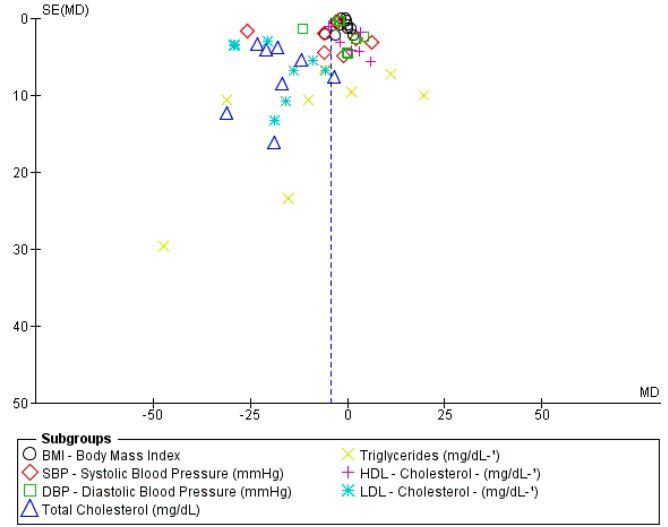
Scheme 4. Funnel plot of the pooled meta-analysis of biomarker intervention studies. Source: pre- pared by the authors using RevMan 5.4.1 software